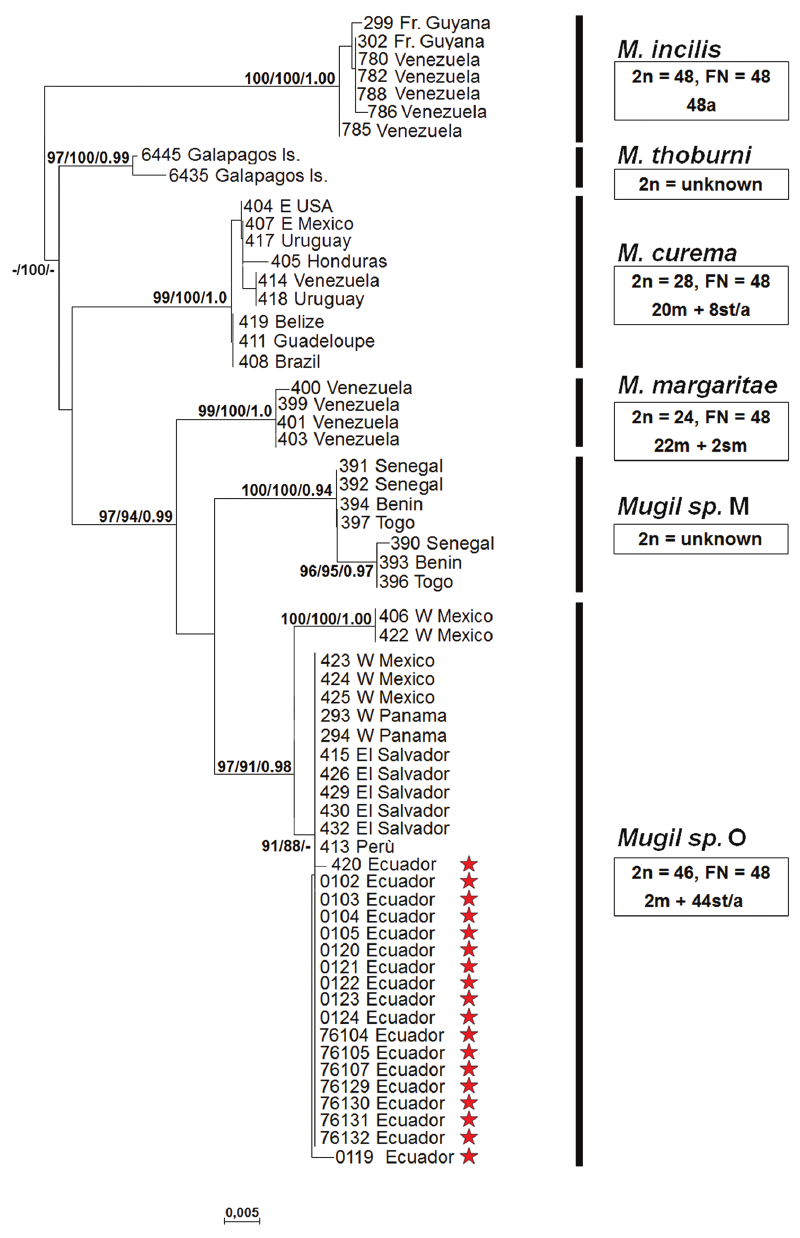
Figure 1. Neighbor-joining tree based on COI sequences. At each node, bootstrap values > 70% (NJ and ML) and posterior probabilities > 0.9 (BI) are shown. Stars indicate sequences obtained in this study; the remaining sequences are from Durand et al. (2012), Durand and Borsa (2015) and from Hett et al. (2011) (see Table 1). For each lineage, the karyotype (2n), the fundamental number (FN) and the chro- mosome formula are indicated. m: metacentric chromosomes; sm: submetacentric chromosomes; st/a: subtelocentric/acrocentric